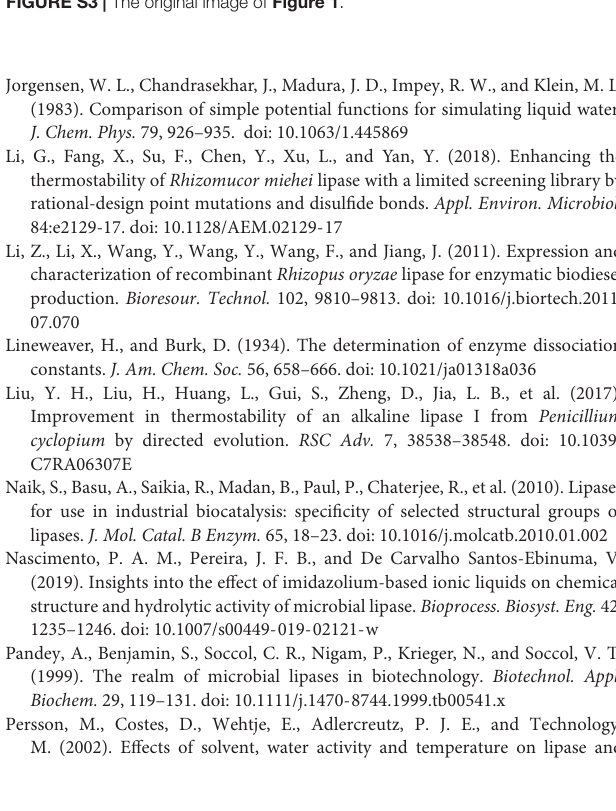
FIGURE S1 | Circular dichroism spectra (CD) of Lipr27RCL (A) , Lipr27RCL-K64N (B) , and Lipr27RCL-K68T (C) under the condition of thermal denaturation at 65 ◦ C for 5 min and renaturation at 4 ◦ C for 2d, respectively. FIGURE S2 | The thermostability of Lipr27RCL, Lipr27RCL-K64N, Lipr27RCL-K68T, and Lipr27RCL-K64N/ K68T at 60 ◦ C. FIGURE S3 | The original image of Figure 1